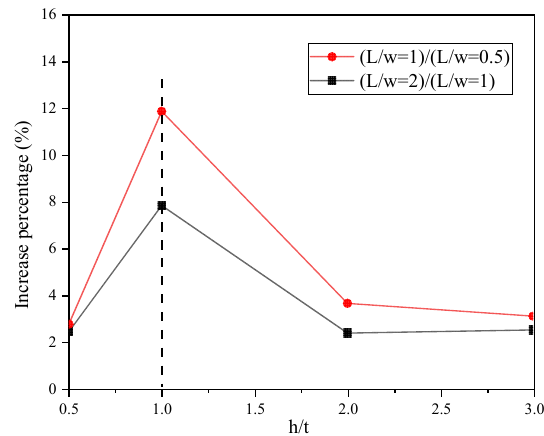
Figure 25. Comparison of repairing effects of different lengths of CFRP.